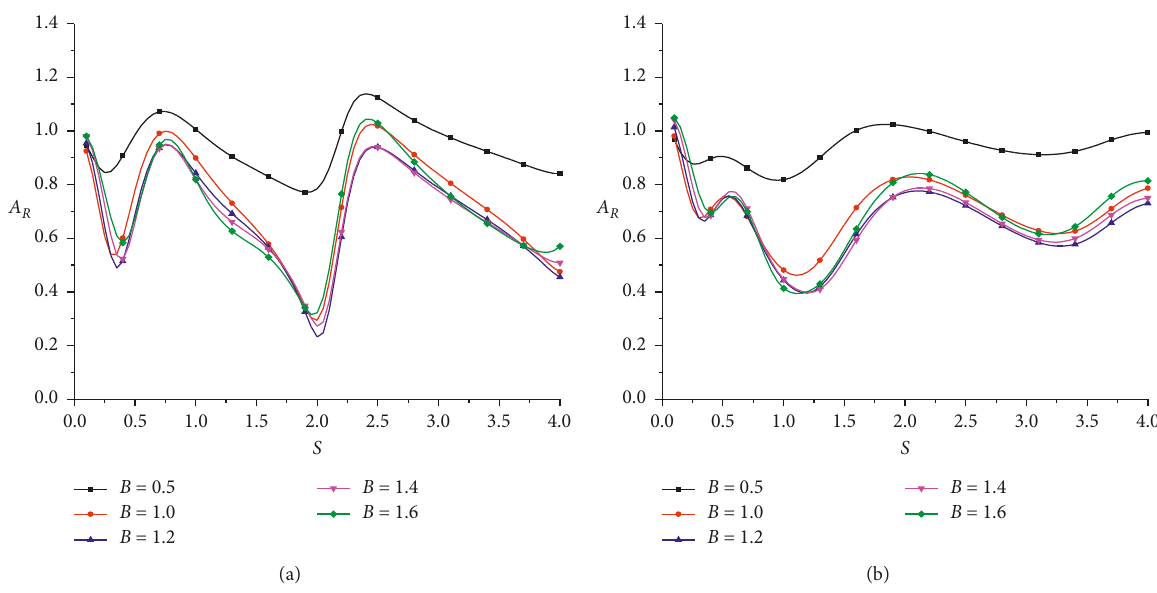
Figure 6: Variation curve of A R of ground displacement with distance for various Duxseal diameters: (a) radial displacement and (b) vertical displacement.